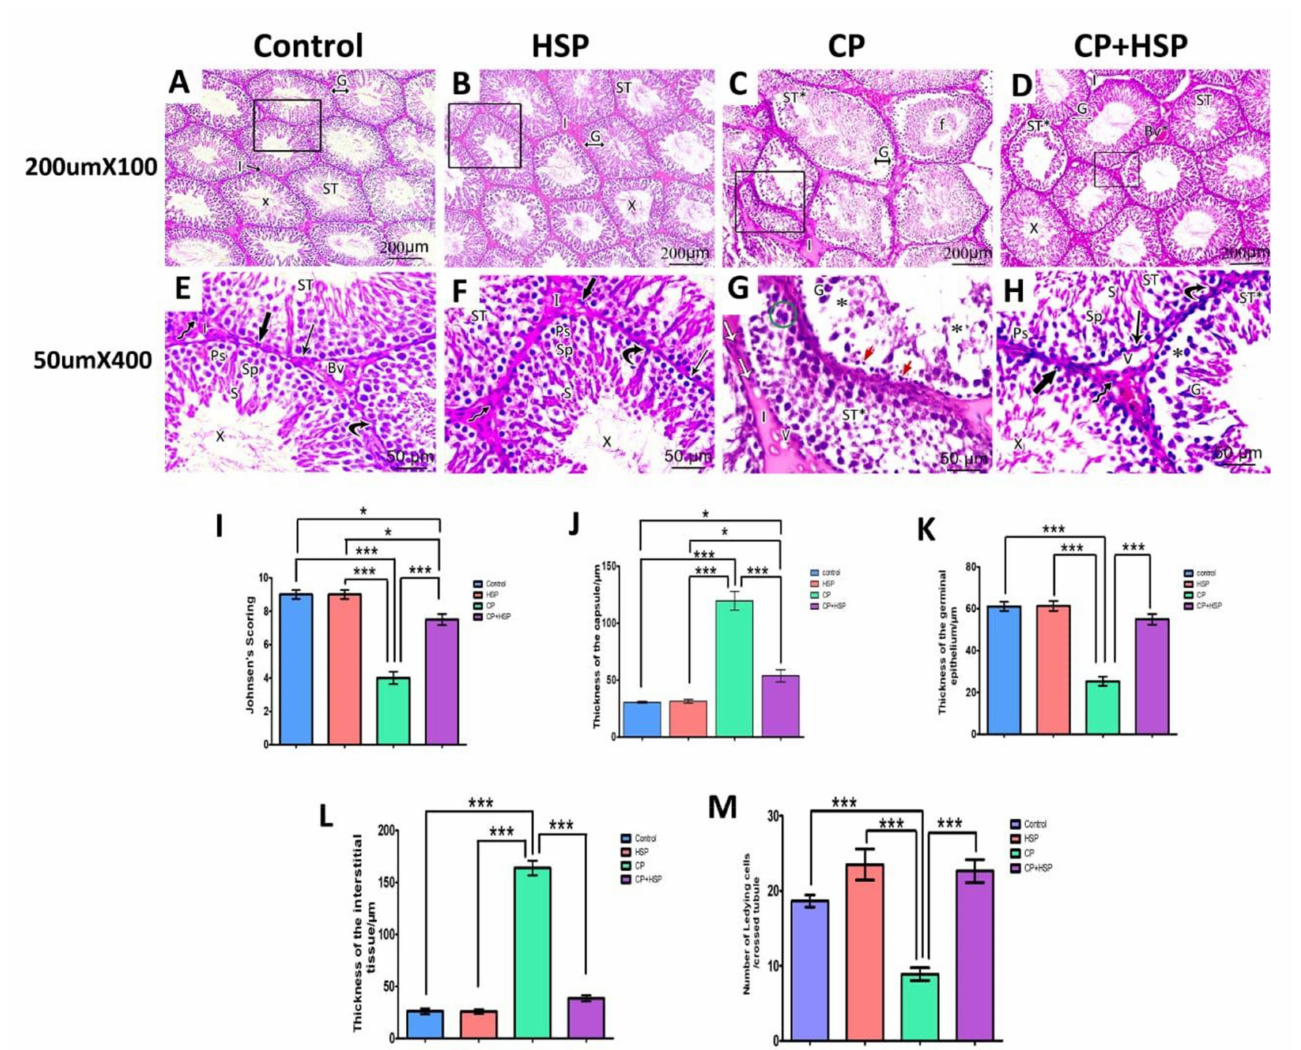
Figure 3. Effect of hesperidin administration in cyclophosphamide-induced testicular impairment in male rats on testicular histopathological and morphometric analysis ( A – M ). ( A ) Seminiferous tubules (ST) lined with stratified germinal epithelium (G). Aggregation of sperm is seen in their lumina (X). Narrow interstitial spaces (I), H&E X100. ( B ) Seminiferous tubules are closely packed (ST) and lined by stratified germinal epithelium (G). Clumps of sperm are seen in their lumina (X). A narrow interstitium is seen in between the tubules and contains clusters of cells (I), H&E X100. ( C ) Distorted seminiferous tubule (ST*) with irregular outlines and atrophied layers of germinal epithelium (G) with exfoliation of some germ cells towards the lumen (f). The interstitial tissues are wide and edematous (I), H&E X100. ( D ) Well-organized seminiferous tubules (ST) with a normal regular outline of germinal epithelium (G) and aggregation of sperm in their lumina (X). Other tubules appear affected with detached germinal epithelium and empty lumen (ST*). Relatively narrow interstitial spaces (I) between tubules and congested blood vessels (Bv*) are seen, H&E X